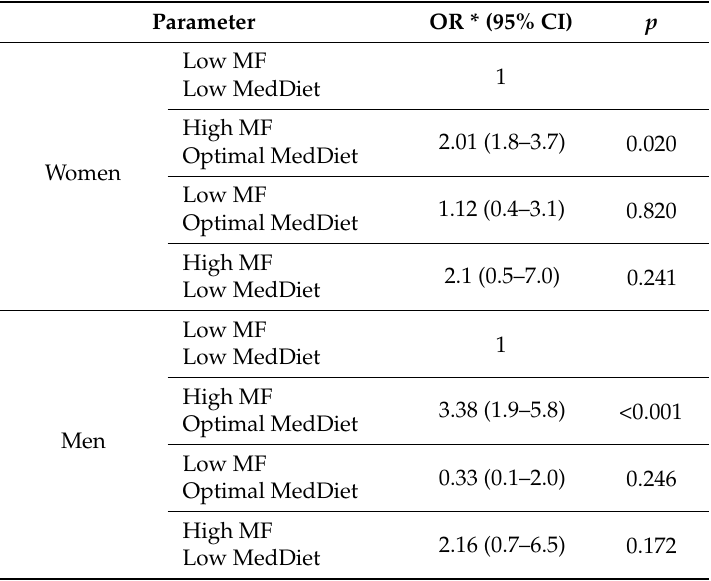
Table 3. Odds ratio of having a healthier metabolic profile by adherence to a Mediterranean diet and muscular